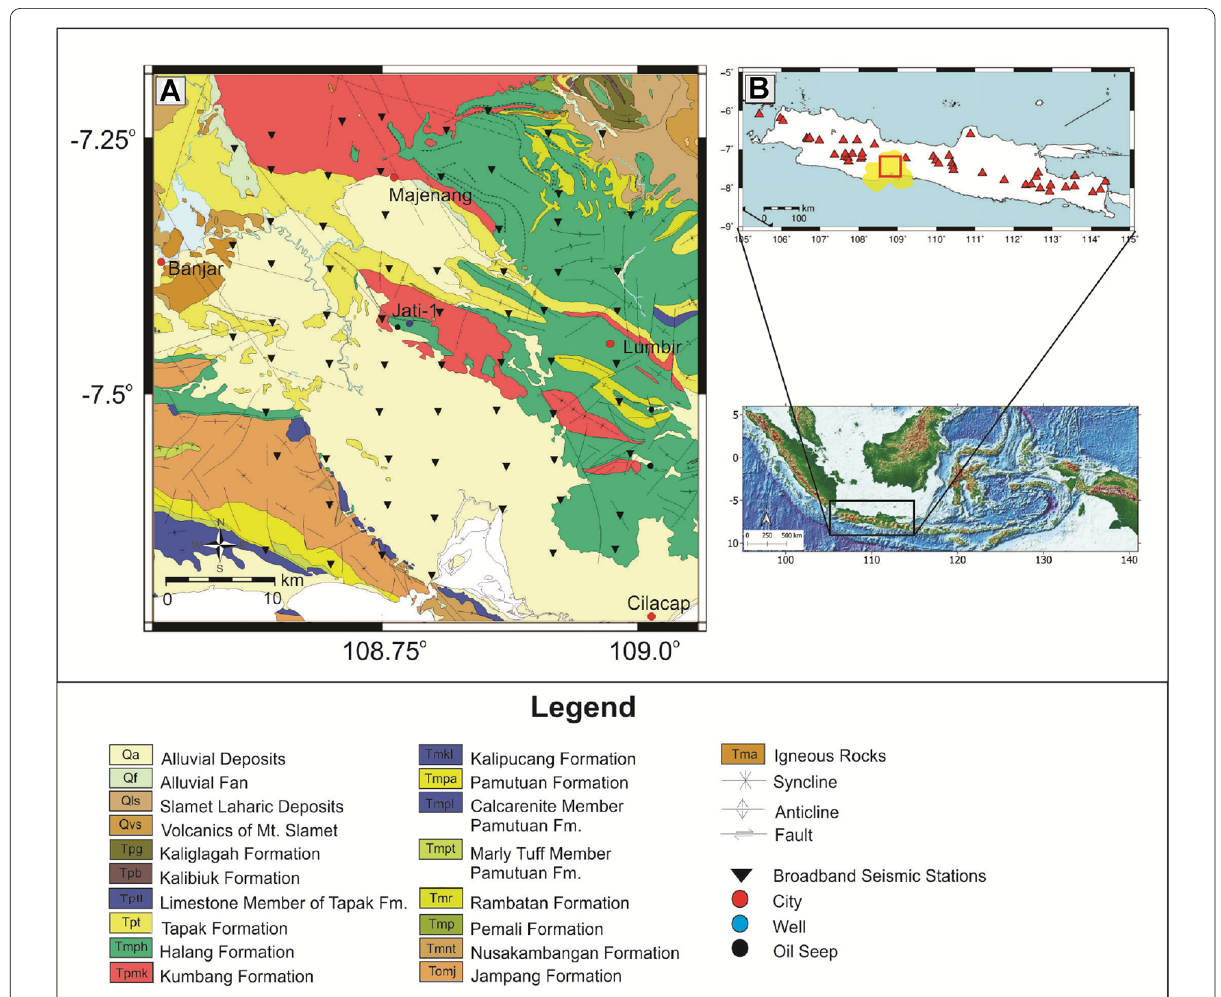
Fig. 1 A Geological map of the study area (modified from Simandjuntak and Surono 1992; Kastowo and Suwarna 1996; Djuri et al. 1996; Asikin et al. 1992); B inset map of survey location. The yellow area is the Banyumas Basin (Geologi 2009), the red square shows the survey location, and the red triangle is a volcano on Java